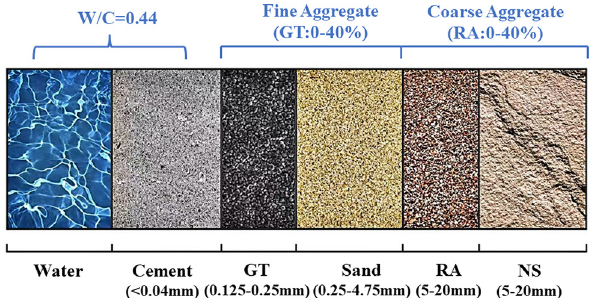
Figure 4: The substitution methods for RA and